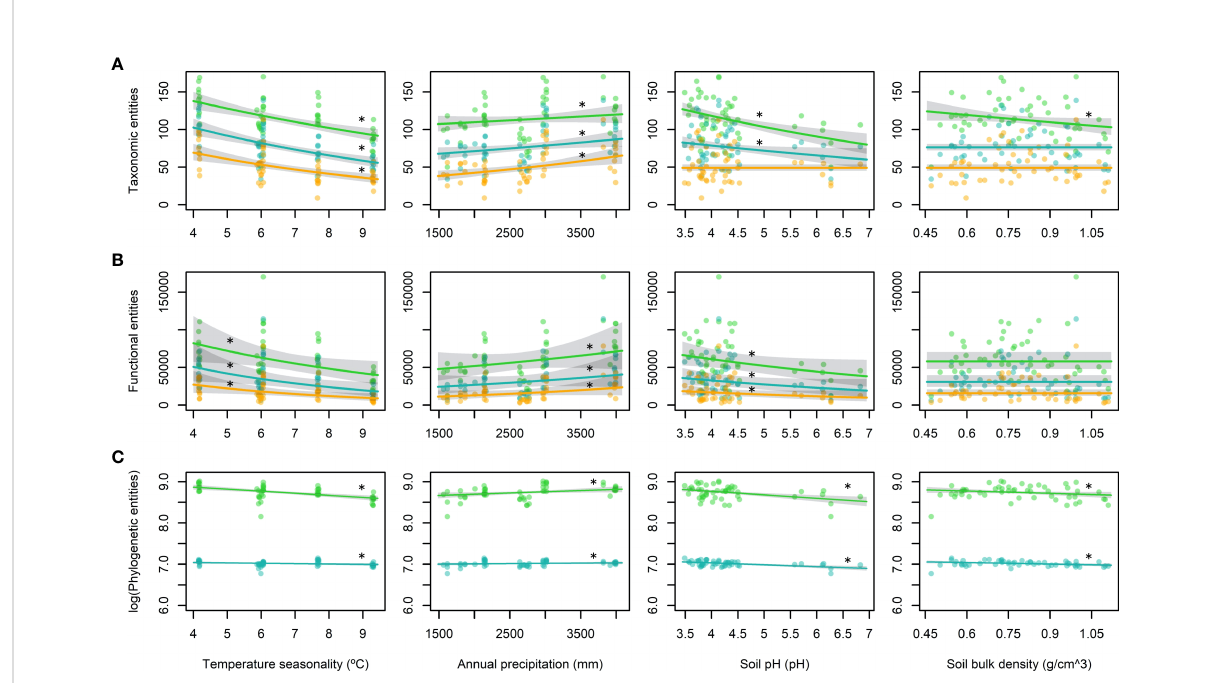
FIGURE 4 Predictions of the best- fi t generalized linear mixed models (GLMMs) with 95% con fi dence intervals for each diversity attribute: (A) taxonomic entities, (B) functional entities, and (C) phylogenetic entities. Hill numbers are shown in different colours: q = 0 in green, q = 1 in blue, and q = 2 in yellow. Each column corresponds to one of the terms included in the models: temperature seasonality (left column), annual precipitation (central left column), soil pH (central right column), and soil bulk density (right column). Terms included in the best- fi t model are marked with